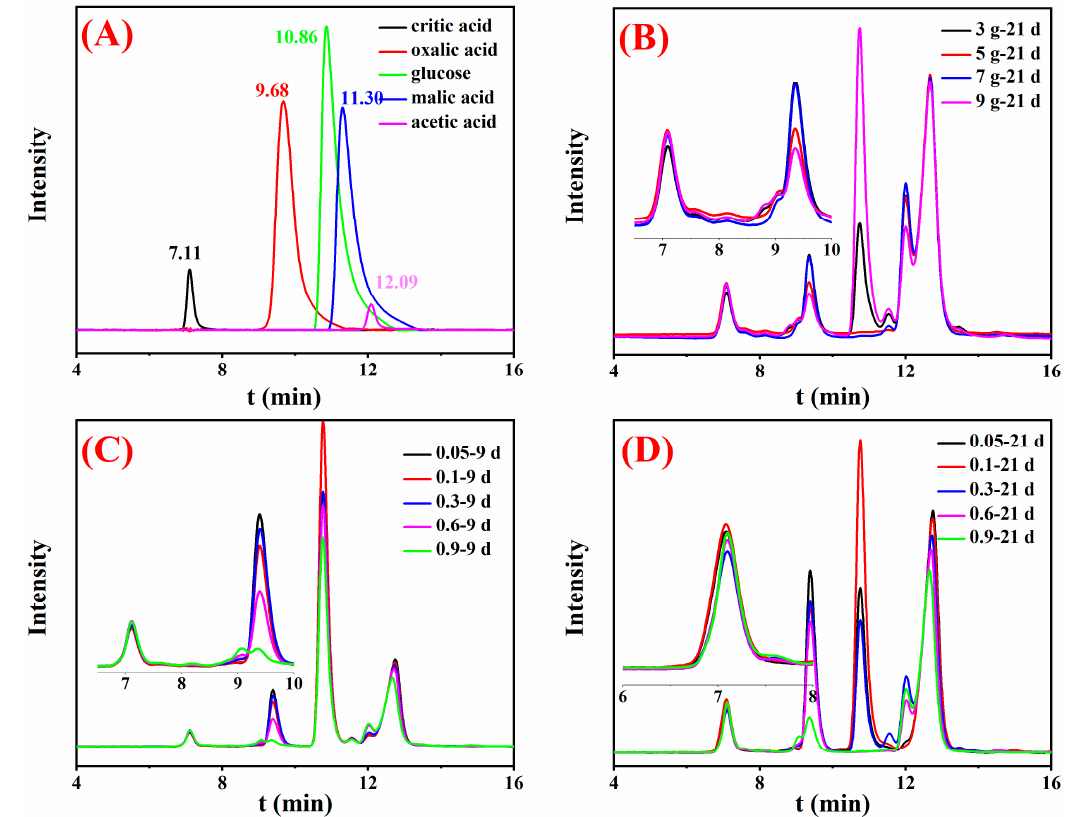
Figure 6. HPLC results of the standard samples ( A ) and the medium supernatant under di ff erent conditions: di ff erent contents of CCA-treated wood for 21 days ( B ), di ff erent concentrations of Y. lipolytica for 9 days ( C ), and di ff erent concentrations of Y. lipolytica for 21 days ( D ).